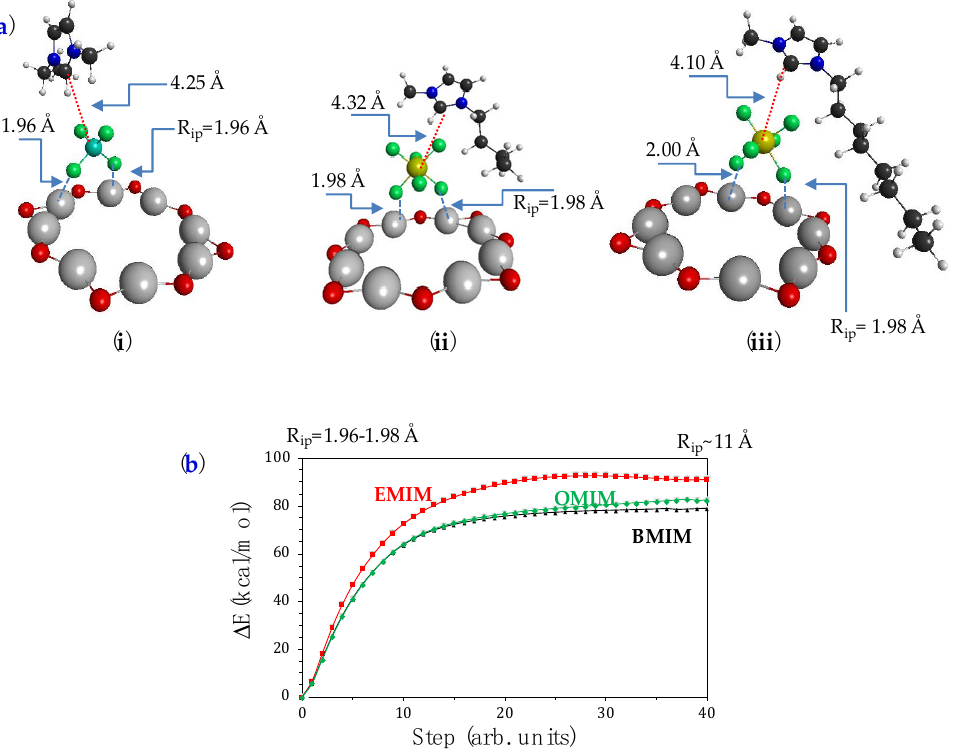
Figure 3. ( a ) CAM-B3LYP/def2-SVPP minimum energy geometries of IL/NAPS systems with (i) EMIMBF4; (ii) BMIMPF6; (iii) OMIMPF6. ( b ) Potential energy profiles of the imidazole moiety/NPAS systems formation-dissociation processes. Table 3. Formation electronic energies in kcal/mol of the imidazole moiety/NPAS systems.